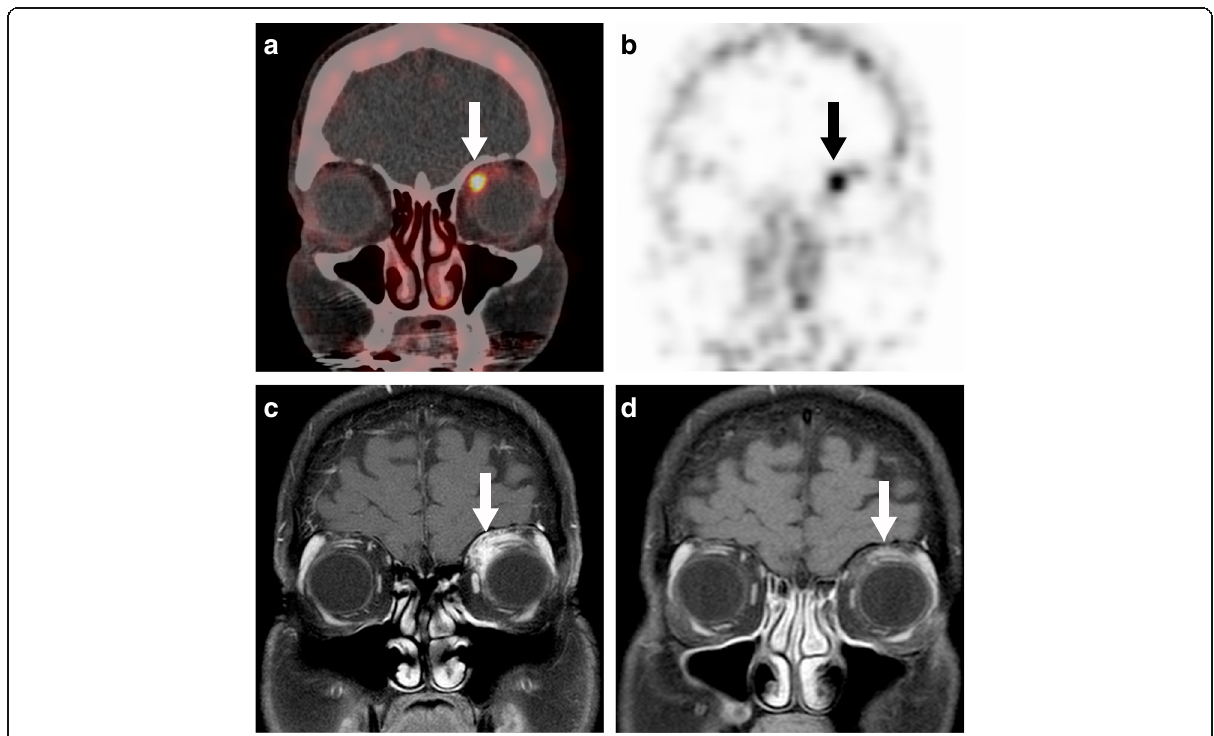
Fig. 3 Rituximab treatment response (case 7). a 89 Zr-rituximab PET/CT fusion image with focal uptake in the lesion, white arrow points at the lesion. b PET only image, black arrow points at the lesion. Initial ( c ) and post-treatment MRI at 3 months after treatment ( d ), illustrating treatment